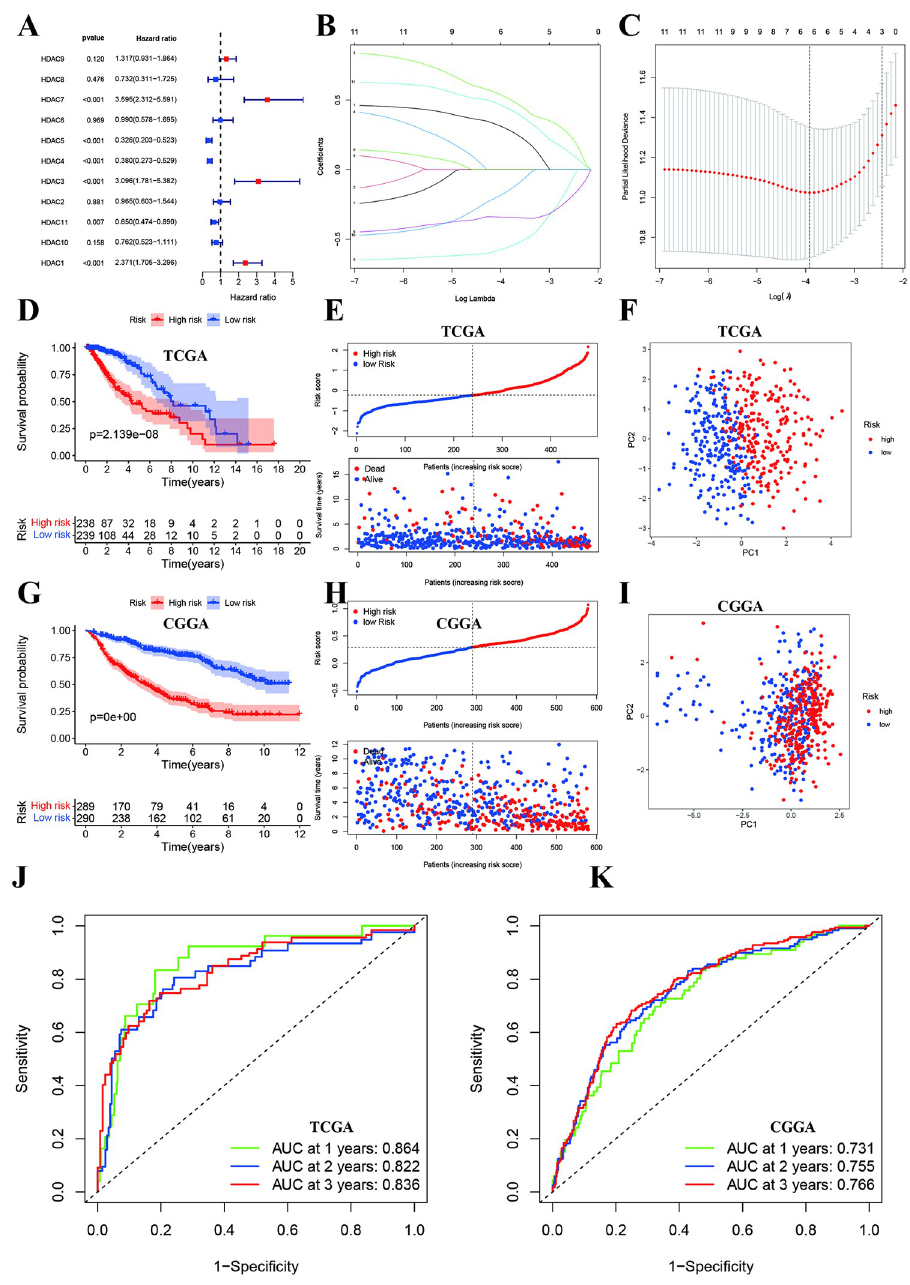
Fig 2. Development and validations of a prognostic signature based on HDAC genes. A: Forest plot of univariate cox regression for HDAC genes. B and C: LASSO regression identified the HDAC genes included in the model. D: Kaplan-Meier survival cures of high- and low-risk groups in TCGA. E: Risk score and survival time distributions of high- and low-risk groups in TCGA. F: PCA indicated two components in TCGA. G: Kaplan-Meier survival cures of high- and low-risk groups in CGGA. H: Risk score and survival time distributions of high- and low-risk groups in CGGA. I: PCA indicated two components in CGGA. J and K: Time-independent ROC for predicting survival at 1-year, 2-year, and 3-year using TCGA and CGGA datasets.